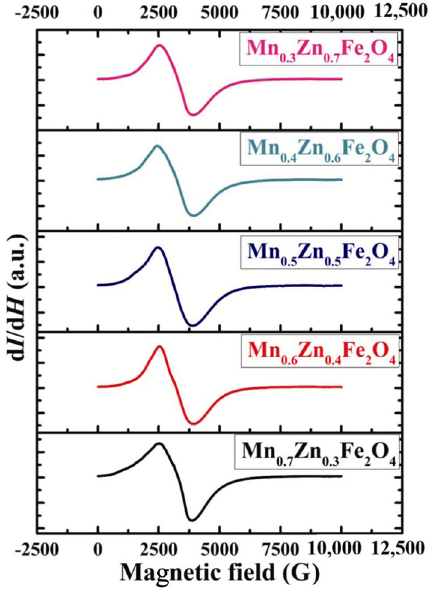
Fig. 6 Variation of (d I /d H ) with magnetic field